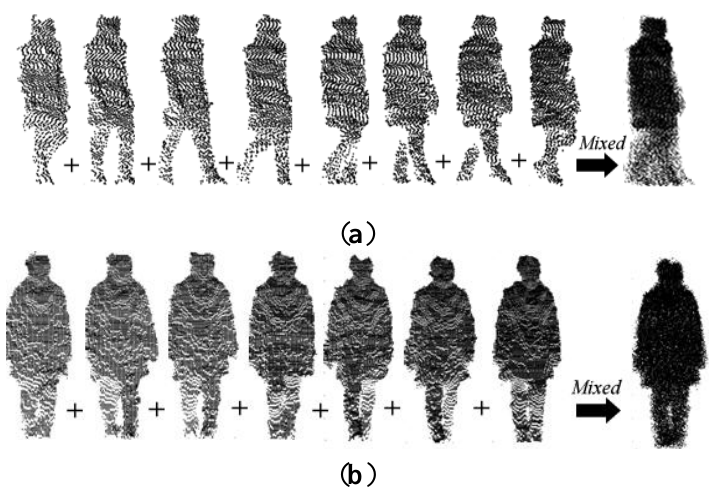
Figure 6. Gait point cloud alignment and mixed gait modeling in a cycle: ( a ) 0° gait view; and ( b ) 90° gait view.